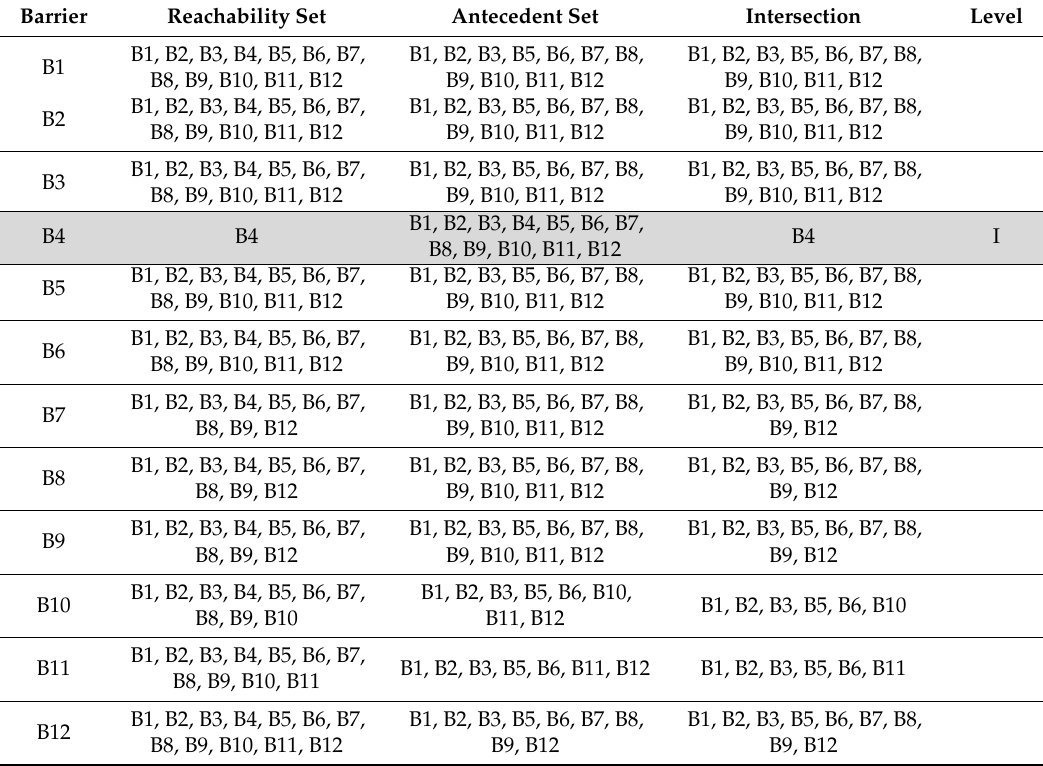
Table 5. Partition matrix (PM) and barrier (B1–B12) levels—1st iteration of ISM